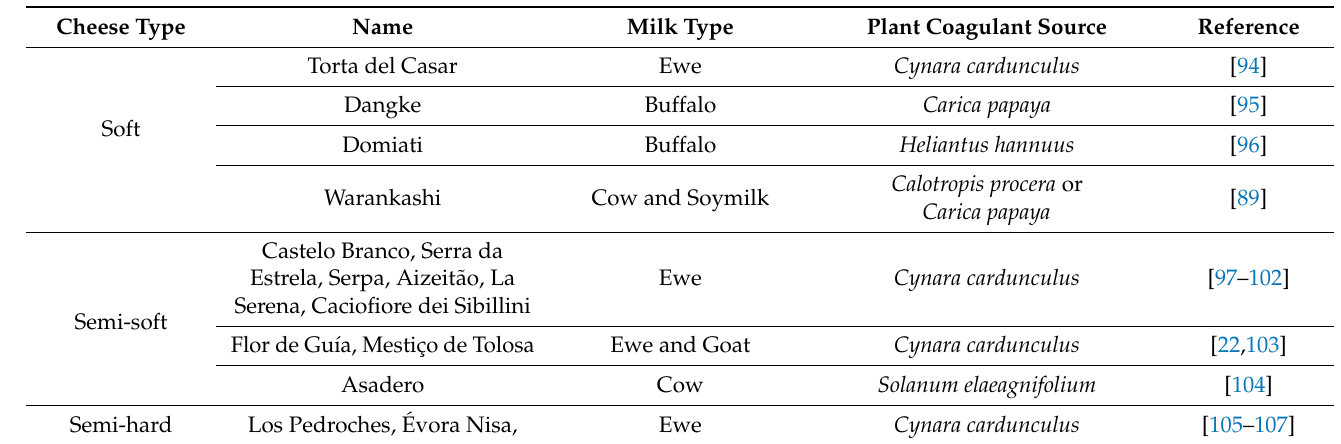
Table 4. Cheese types in relation to plant